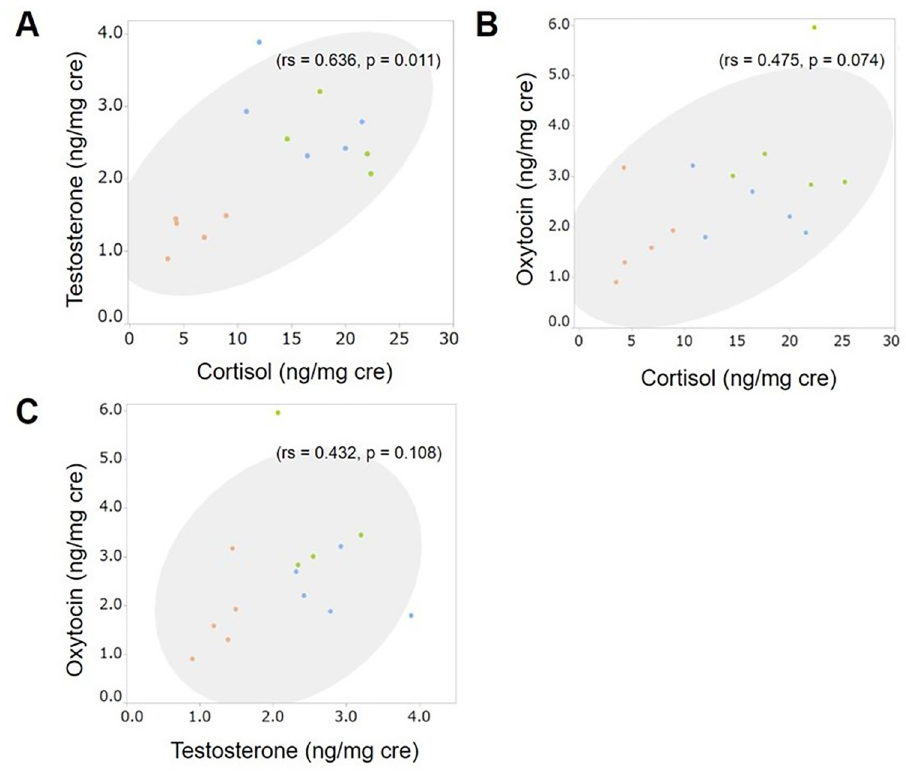
Fig 1. Correlations among different hormones (cortisol, testosterone, and oxytocin). Fig 1A shows the correlation between cortisol and testosterone, 1B shows the correlation between cortisol and oxytocin, and 1C shows the correlation between testosterone and oxytocin. Each group is color coded. Each point represents the average hormone concentration for each individual. The gray circle is a 95% confidence ellipse. (S3 Fig). Next, to investigate whether the compositions of the microbiomes are affected by con- tact with other individuals, we analyzed the correlations among UniFrac distances, which indi- cates similarity of gut microbiomes between individuals, and the interactions among the cats. Negative correlations were observed with respect to some of the behaviors, namely sharing a bed, entering bed, grooming, and sniffing (S6 Table). Hence, the greater the similarity in gut microbiome, the greater the sharing bed (Fig 2A, rs = − 0.679, p < 0.001), entering bed (Fig 2B, rs = − 0.395, p = 0.037), and sniffing (Fig 2C, rs = − 0.446, p = 0.018). Correlations of gut microbiome with hormone concentrations as well as behaviors of the cats. The correlations between each component of the axis based on PCoA of the microbes and hormone levels in the cats (S7 Table) as well as those between the PCoA and cat behavior (S8 Table) were analyzed. PCoA2 was correlated negatively with cortisol concentra- tion (rs = − 0.714, p = 0.047) and positively with rubbing (total: rs = 0.819, p = 0.013), following (total: rs = 0.747, p = 0.033), sharing of food (rs = 0.733, p = 0.039), and sniffing (rs = 0.738, p = 0.037) behaviors. Additionally, PCoA3 was correlated positively with entering bed (active: rs = 0.762, p = 0.028; passive: rs = 0.781, p = 0.022; total: rs = 0.762, p = 0.028), and was corre- lated negatively escaping behavior (rs = − 0.903, p = 0.002). PCoA5 was correlated positively with cortisol concentration (rs = 0.762, p = 0.028), and negatively with following behavior (active: − 0.866, p = 0.005). Moreover, PCoA8 was correlated with attacking behavior (rs = − 0.714, p = 0.047).